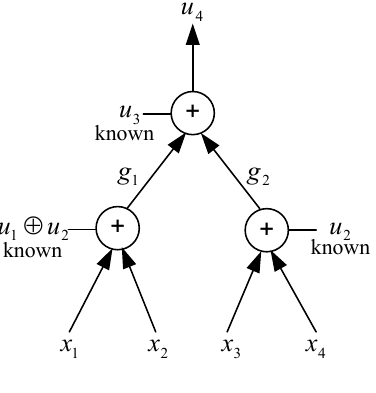
Figure 7 Decoding tree of 𝑢